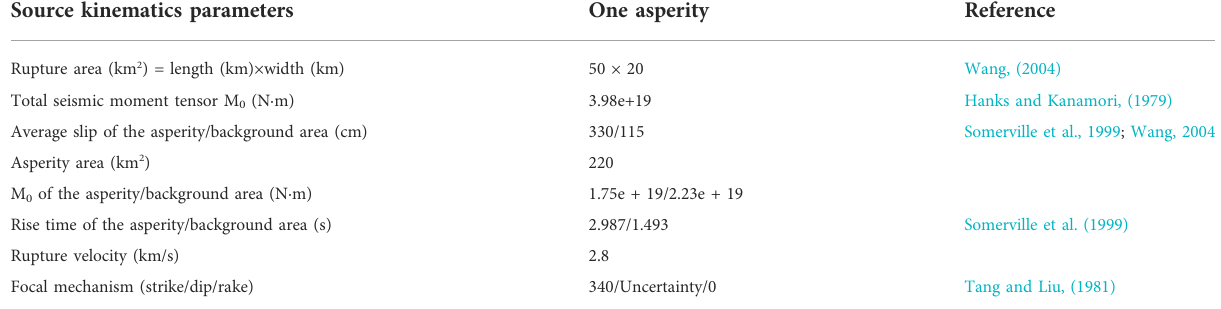
TABLE 1 Source parameters used by the fi nite difference method in the Pingwu scenario earthquake.